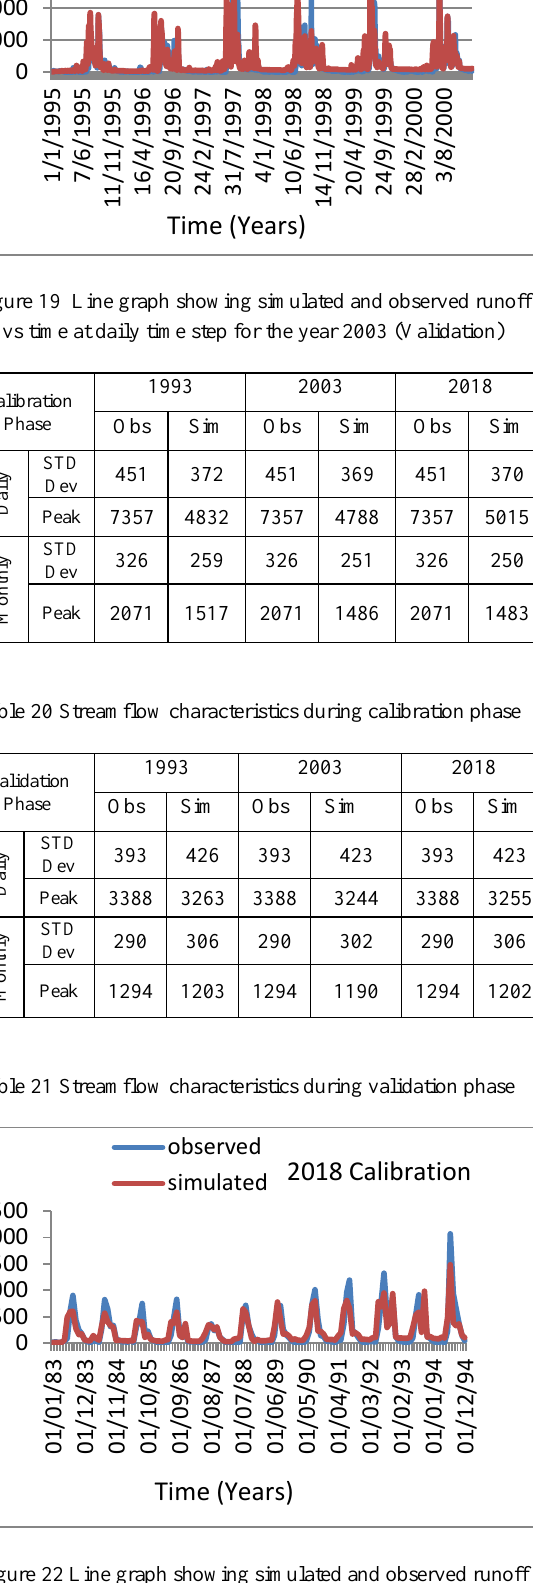
Figure 22 Line graph showing simulated and observed runoff vs time at monthly time step for the year 2018 (calibration)